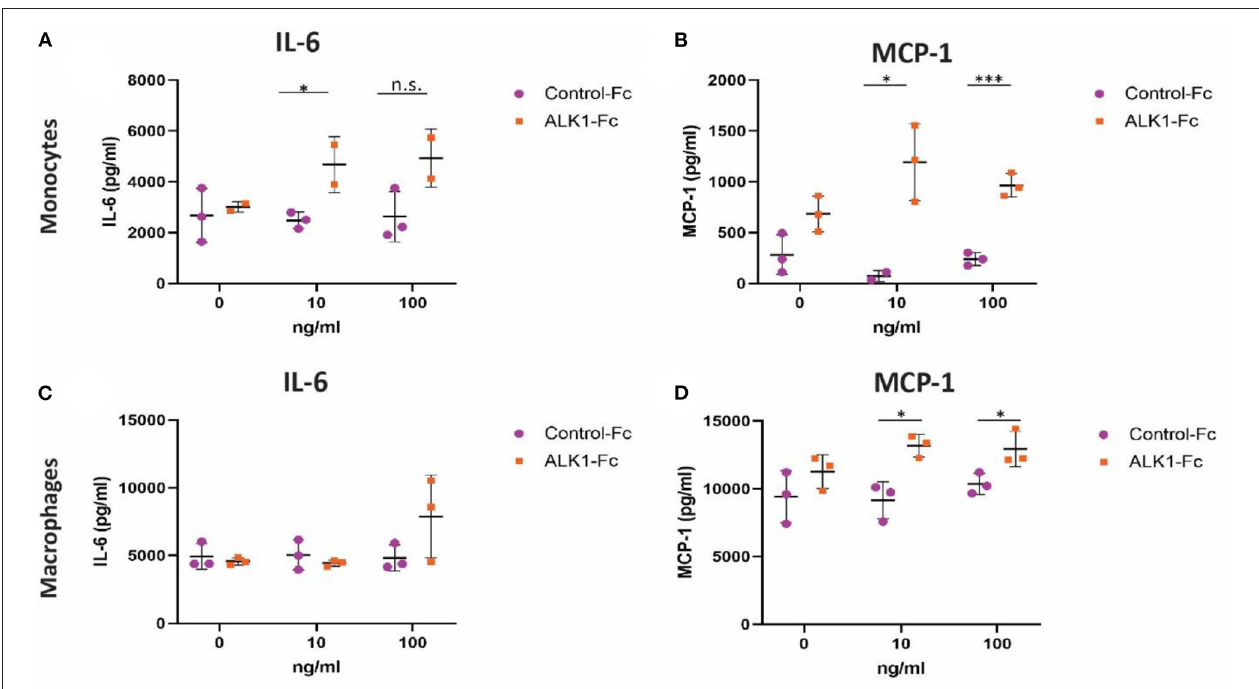
FIGURE 5 | Production of pro-inflammatory cytokine IL-6 and chemokine MCP-1 by LPS-stimulated macrophages and monocytes upon treatment with ALK1-Fc or control-Fc. Monocytes ( n = 3 experiments) and macrophages ( n = 3) treated with 0, 10, or 100ng/ml ALK1-Fc or control-Fc subsequently stimulated with 10ng/ml LPS. The IL-6 (A,C) and MCP-1 (B,D) concentrations were determined in the supernatant. Statistical evaluation was performed with the unpaired parametric T -test, * p < 0.05, ** p < 0.01, *** p < 0.001. n.s. =